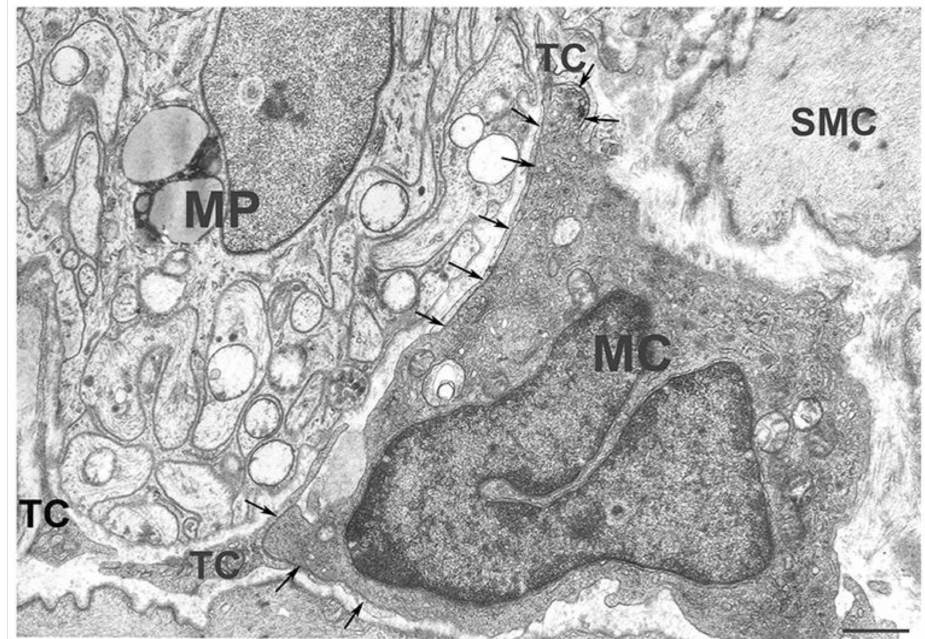
Figure 2. Transmission electron microscope. Human colon. Myenteric plexus. Some long and thin TC processes encircle a ganglion and make extended contact with an MC (arrows) The image was reproduced from those reported in the paper [28]. Scale bar= 0.6 µ m.